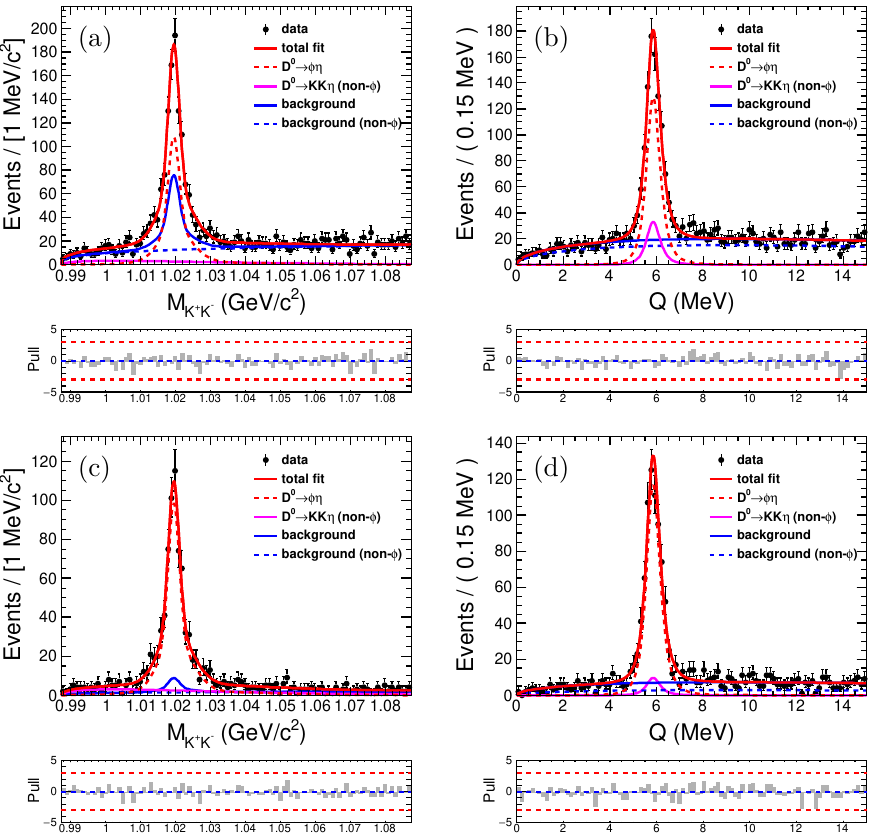
Figure 4 . Projections of K + K − invariant mass distributions in Q (a) fit region and (c) signal region ( | Q − 5 . 86 | < 0 . 8 MeV) and Q distributions in M (b) fit region and (d) signal region K + K − ( | M − m φ | < 10 MeV/ c 2 ) from the M KK - Q two-dimensional fit. Points with error bars are K + K − the data. The red solid line is total fit result. The red dashed curves are signal of D 0 → φη , and the magenta solid curves show the Q -peaking background from non- φ component in D 0 → K + K − η . The blue dash line is the non- φ component of total non- Q -peaking background (blue line).